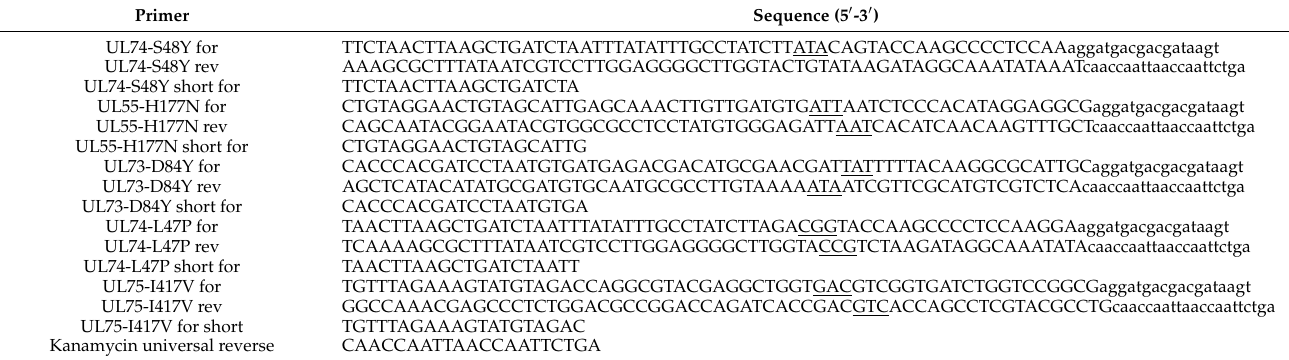
Table 1. Primers used for the introduction of candidate resistance-conferring mutations into the genome of HCMV pHB5. Primer